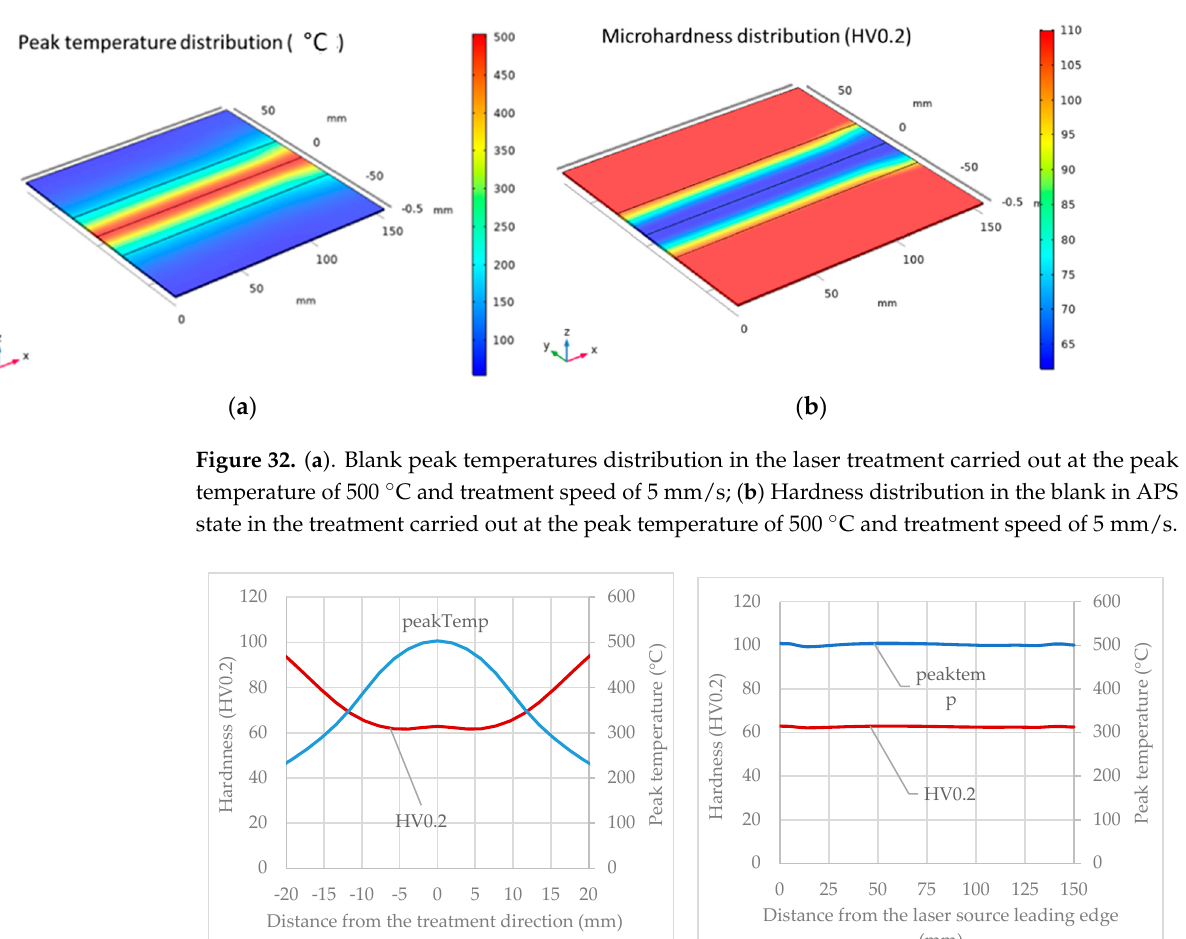
Figure 31. ( a ) Hardness and peak temperature profiles evaluated transversely to the treatment direction (T420V5-T4); ( b ) Hardness and peak temperature profiles evaluated along the treatment direction (T420V5-T4). Figure 32a shows the peak temperature distribution computed at the end of the T500V5 laser treatment simulation; for this laser treatment condition, Figure 32b shows the microhard- ness distribution computed when the blank is assumed in the APS state (T500V5-APS). Figure 33 shows the corresponding hardness and peak temperature profiles that were transversely evaluated (x = 75 mm) and along the laser treatment direction (y = 0 mm).